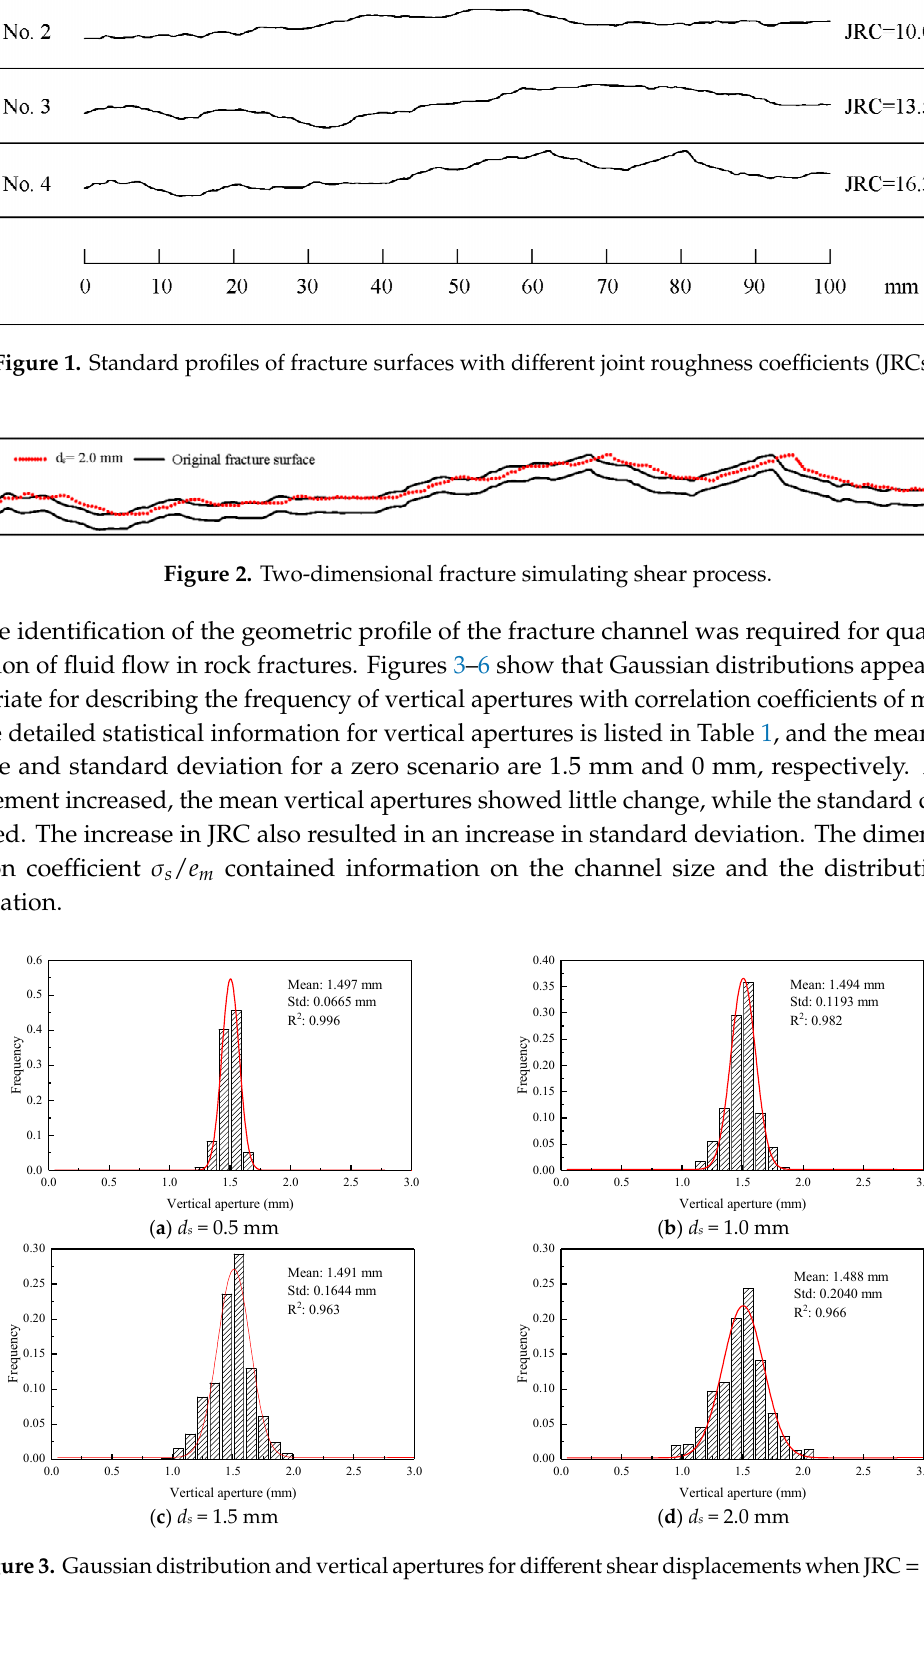
( a ) d s = 0.5 mm ( d ) d s = 2.0 mm Figure 4. Gaussian distribution and vertical apertures for different shear displacements when JRC = 10.02.